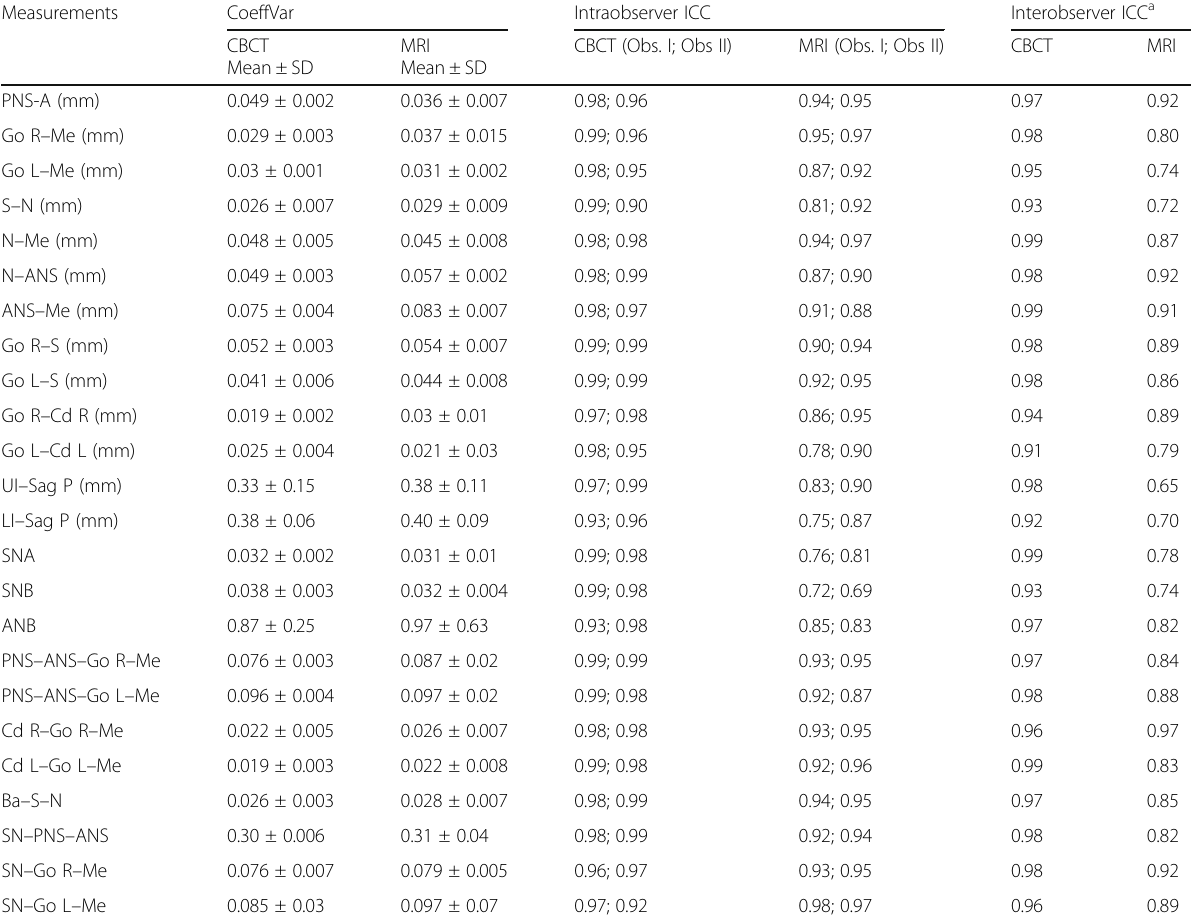
Table 2 Coefficient of variation, Intraobserver and interobserver agreement for three dimensional cephalometric measurements